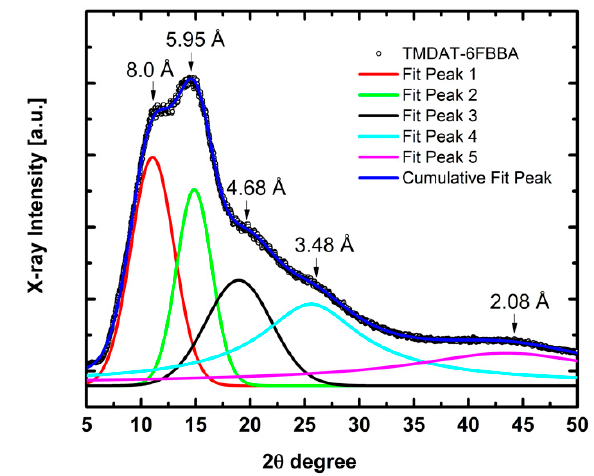
Figure 7. WXRD spectrum of 6FBBA-TMDAT polyamide and peaks deconvolution.